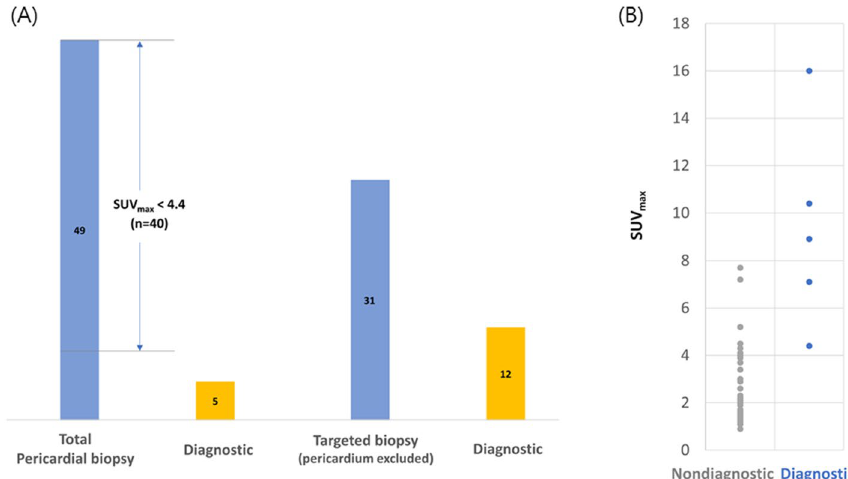
Figure 3. ( A ) A scatter plot of the pericardial SUV max scores with the diagnostic and nondiagnostic results of the pericardial biopsy. ( B ) The number of patients who underwent total pericardial biopsy and diagnostic pericardial biopsy/total targeted biopsy (pericardium excluded) and diagnostic targeted biopsy.